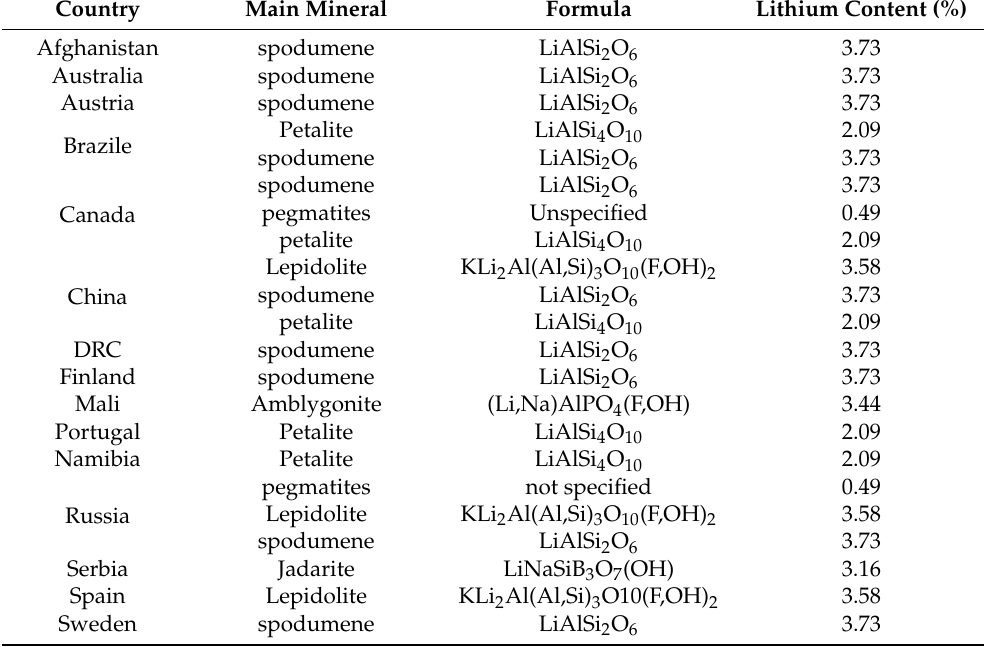
Table 3. Main lithium-bearing minerals that have greater lithium content by countries. Adapted from [18].